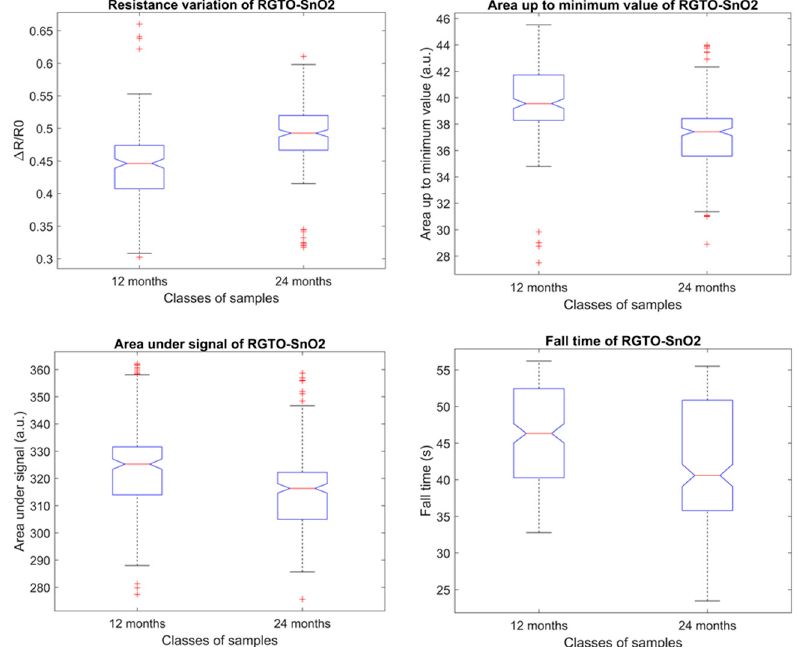
Figure 3. Boxplots of the four features selected in the first step for the RGTO SnO 2 (400 °C) sensor. The median value of the distribution is displayed in red; the red ‘+’ indicates outliers for that distribution. In Table 3, the parameters that have been chosen for the classification process at each step are